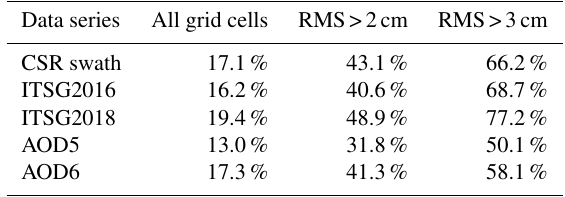
Table 1. Percent of non-coastal ocean area explaining at least 25% of the altimetry sub-monthly variance. The 2 and 3cm RMS bounds are defined in Fig.